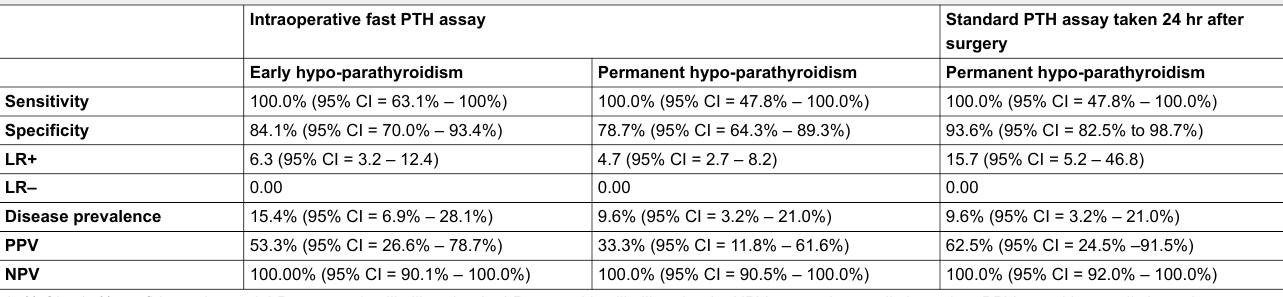
Table 2: Value of intraoperative rapid PTH assay and standard PTH assay taken 24 hours after surgery, for prediction of early and permanent hypoparathyroidism. Intraoperative fast PTH assay Standard PTH assay taken 24 hr after surgery Early hypo-parathyroidism Permanent